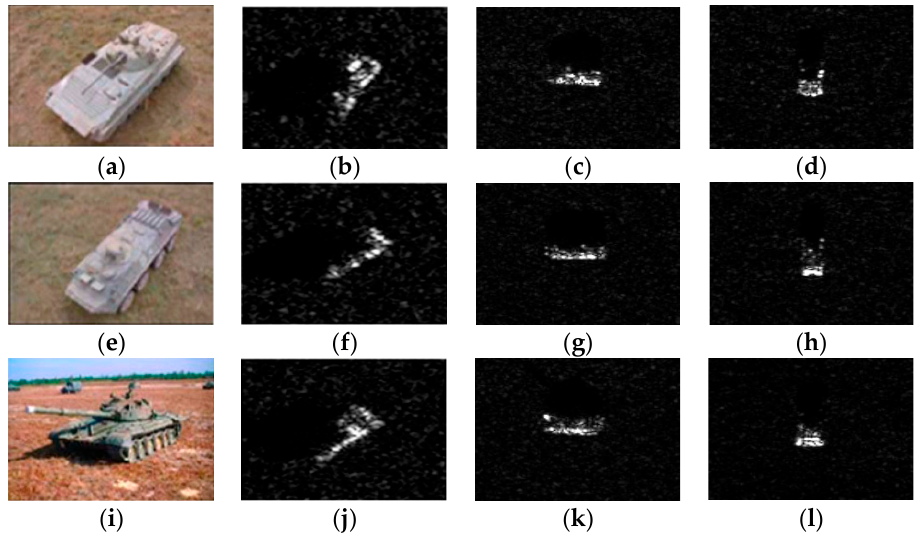
Figure 6. ( a ) Optical image of BMP2. ( b ) SAR image of BMP2 (45.5 ° ). ( c ) SAR image of BMP2 (90.5 ° ). ( d ) SAR image of BMP2 (181.5 ° ). ( e ) Optical image of BTR70. ( f ) SAR image of BTR70 (45.0 ° ). ( g ) SAR image of BTR70 (90.0 ° ). ( h ) SAR image of BTR70 (180.0 ° ). ( i ) Optical image of T72. ( j ) SAR image of T72 (44.8 ° ). ( k ) SAR image of T72 (91.8 ° ). ( l ) SAR image of T72 (180.8 ° ).